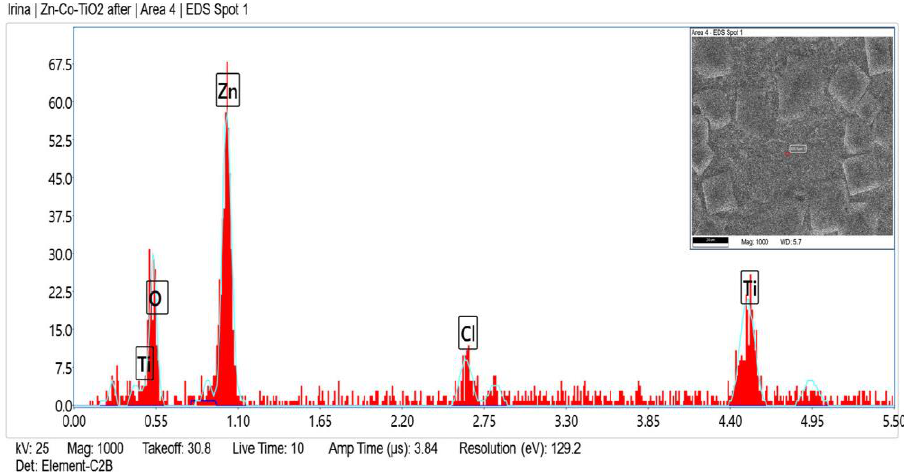
Figure 5. EDX spectrum of System B fresh sample.